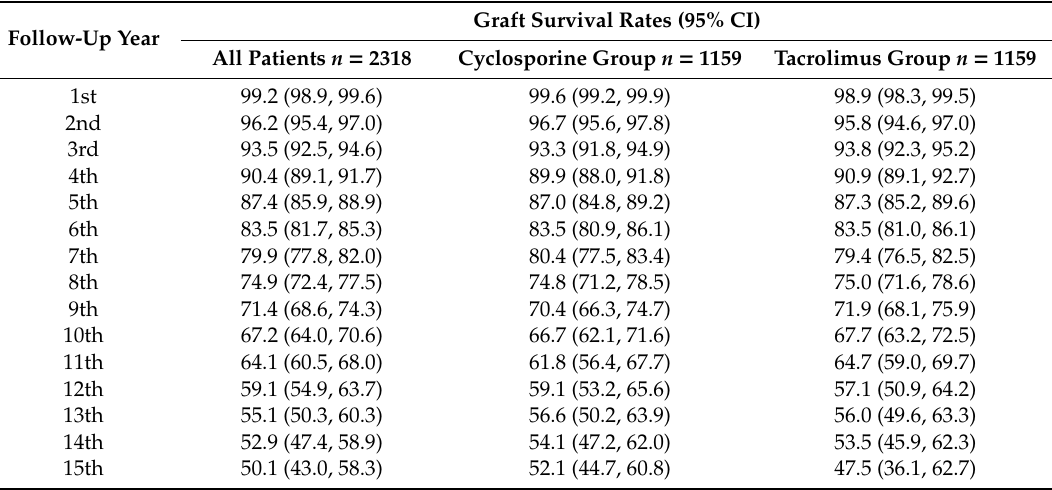
Table 3. Annual graft survival rates of the study patients according to the calcineurin inhibitor group in a matched cohort (Brazil, 2000 to 2015; n =